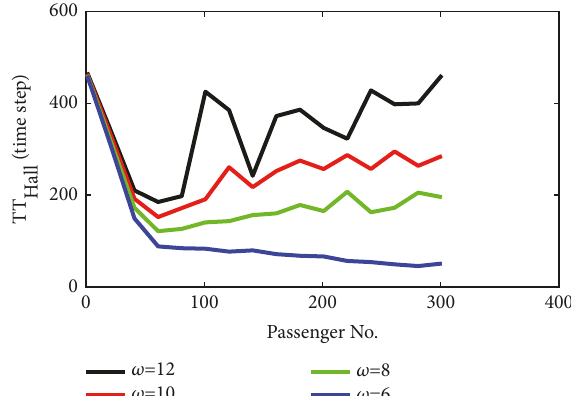
Figure 4: The passenger’s motion time at the waiting hall during the check-in process under different 𝜔 , where the passenger’s no. from 1 to 320 shows each passenger’s entry order at one entrance of the waiting